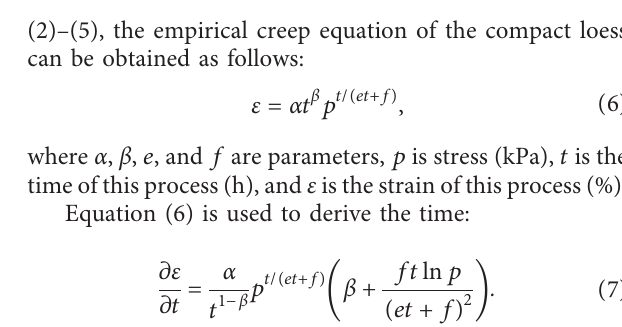
Figure 4: Stress-strain curves of compacted loess with different water content. (a) Water content is 6%. (b) Water content is 10%. (c) Water content is 14%. (d) Water content is